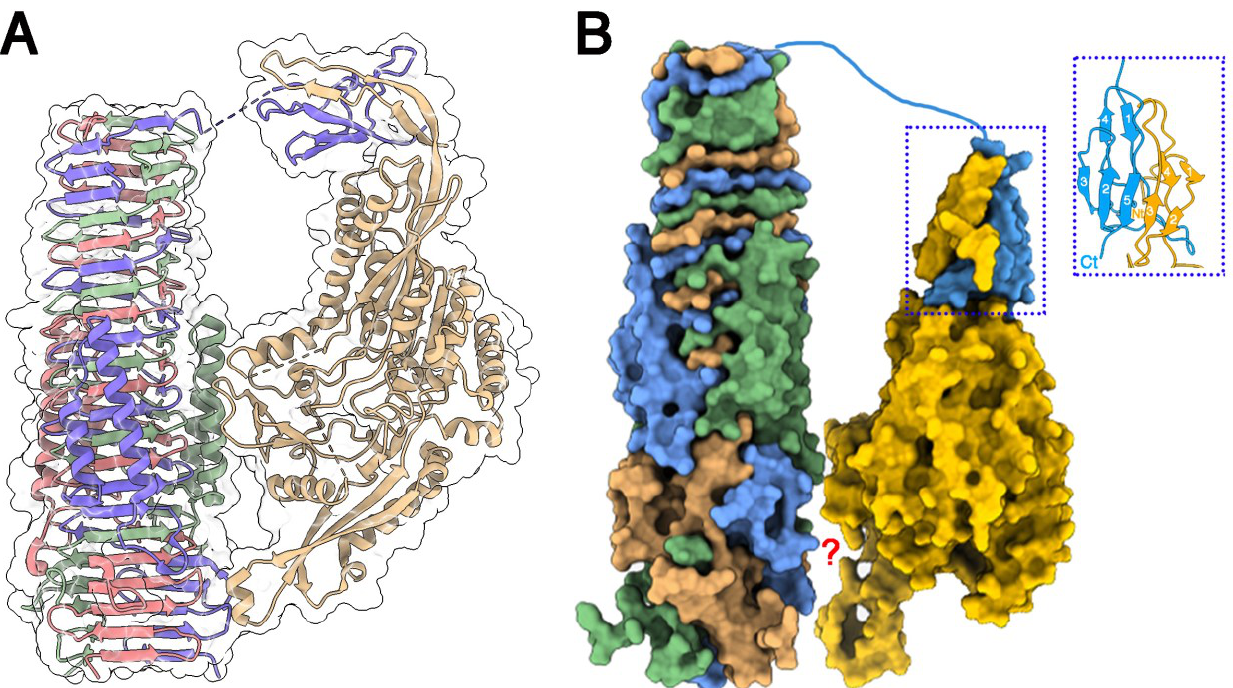
Figure 6. Structure of Tle1 EAEC and Tle3 AIEC , and their interaction with VgrG EAEC and VgrG AIEC . ( A ) Ribbon representation of the cryoEM structure of Tle1 EAEC in complex with VgrG EAEC . VgrG EAEC is colored magenta, violet and green. Tle1 EAEC is colored beige. Surfaces are colored white and transparent. ( B ) Surface representation of the predicted structure of Tle3 AIEC and VgrG AIEC , and a possible mode of interaction in their complex; inset: details of the interaction of VgrG AIEC C-terminal adaptator with Tle3 AIEC N-terminal loop. VgrG AIEC trimer is colored magenta, blue and green. Tle3 AIEC is colored yellow. The blue dot square identify the interaction between VgrG EAEC TTR domain with the N-terminus loop of Tle3 AIEC . The red question mark means that the interaction between the bVgrG EAEC and Tle3 AIEC cores remains unknown.